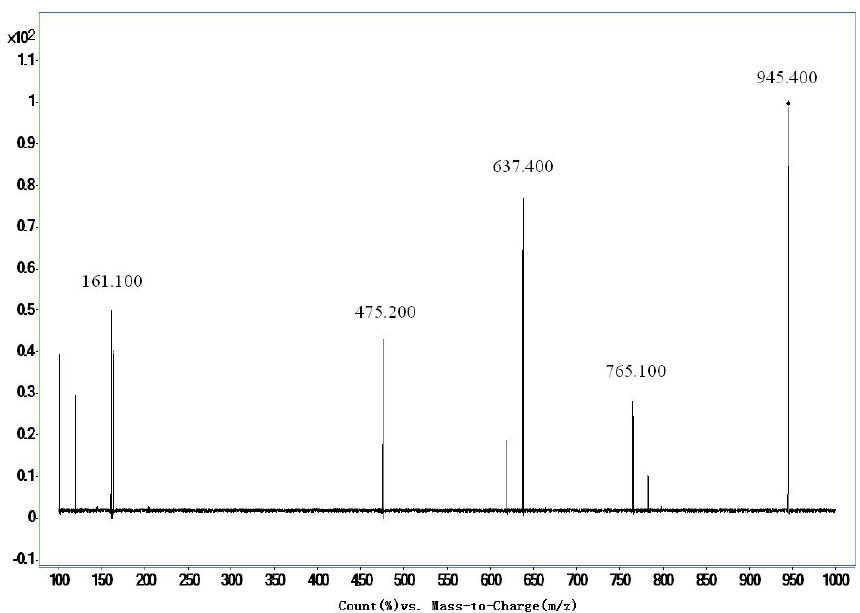
Figure 3. Production spectra of ginsenoside Re